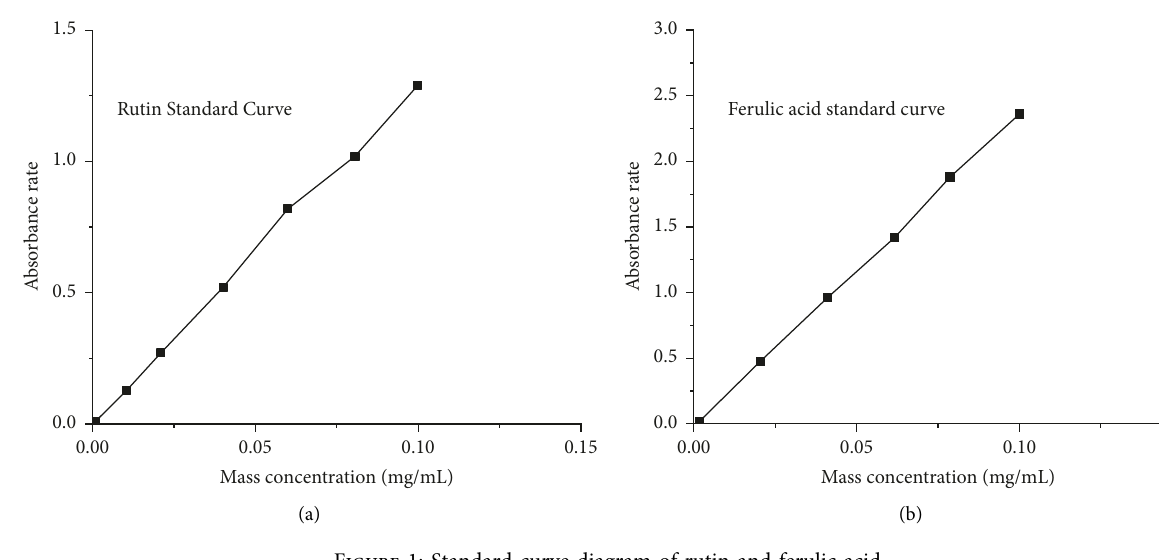
Figure 1: Standard curve diagram of rutin and ferulic